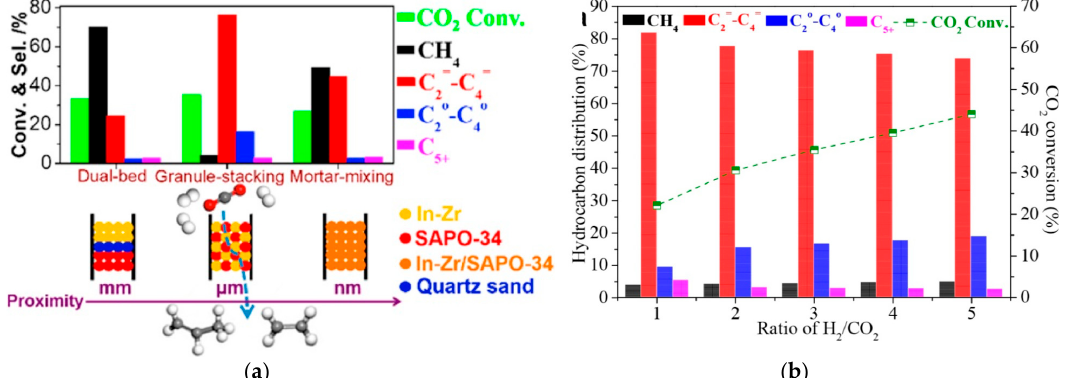
Figure 17. ( a ) Effect of the proximity of the active components on the CO 2 conversion and product selectivity, and ( b ) the catalytic stability of the composite catalyst In-Zr/SAPO-34 (testing conditions: T = 673 K, P = 3.0 MPa, GHSV = 9000 mL g cat − 1 h − 1 , molar ratio of H 2 /CO 2 /N 2 = 73/24/3, and mass ratio of oxide/zeolite = 2). Adapted with permission from ref. [19]. Copyright 2018 American Chemical Society.